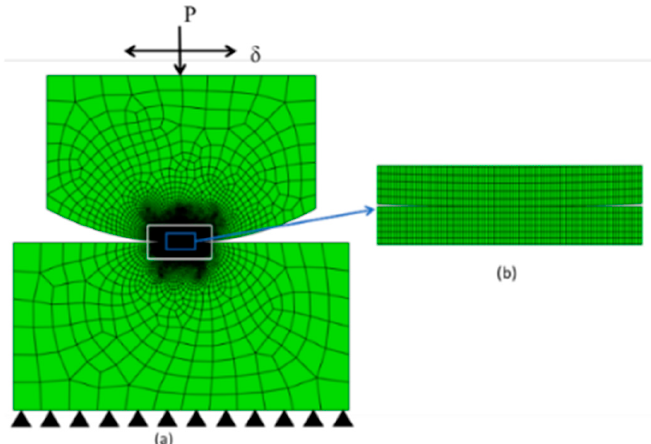
Figure 6. FE model of fretting wear, ( a ) globale view and ( b ) zoom at contact.